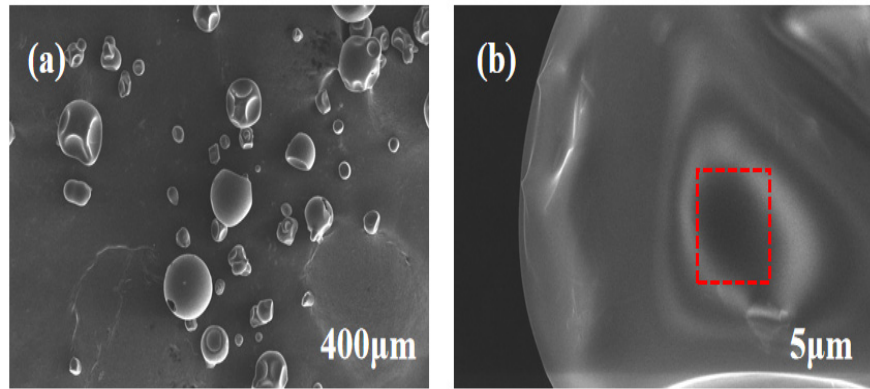
Figure 7. FE-SEM micrograph of tannins ( a , b ). Figure 7. FE − SEM micrograph of tannins ( a , b ). Figure 7. FE − SEM micrograph of tannins ( a , b ).